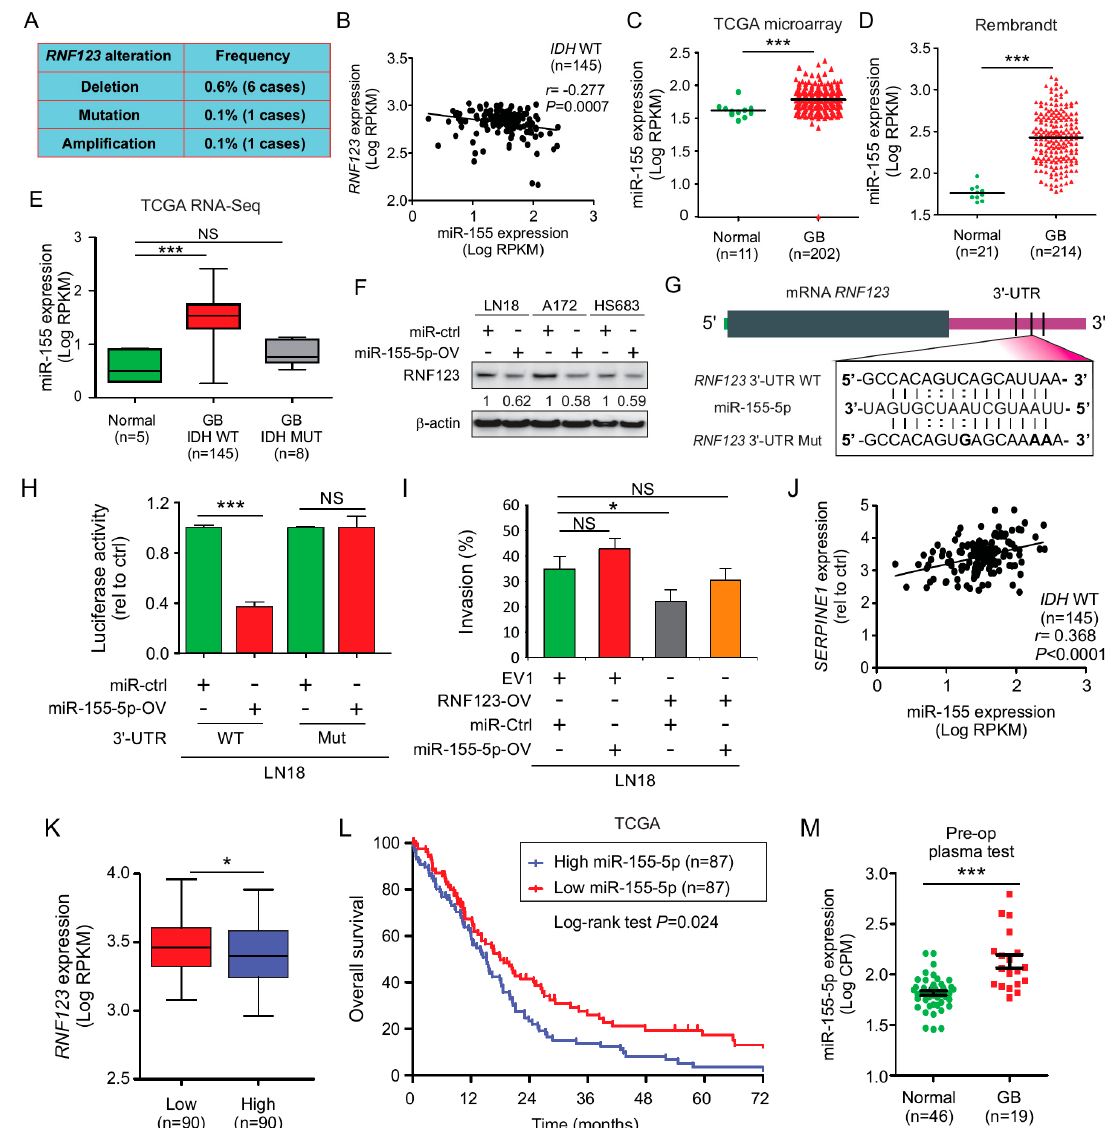
Figure 6. MiR-155-5p decreased RNF123 expression and gave a poor prognosis in GB patients. ( A ) TCGA analysis of a merged cohort of low-grade glioma and GB for copy number variations and mutations. The frequency of RNF123 alteration is 0.8% of a total of 1084 patients. ( B ) Correlation analysis of miR-155-5p and RNF123 expression using TCGA dataset from GB tumors ( n = 145; Pearson r = − 0.277, p = 0.0007). ( C ) TCGA database analysis of miR-155 in GB tissue ( n = 202) compared to normal brain tissue ( n = 11) ( t -test, *** p < 0.001). ( D ) Rembrandt database analysis of miR-155 expression in GB tissue ( n = 214) compared to normal brain tissue ( n = 21) ( t -test, *** p < 0.001). ( E ) TCGA database analysis of RNA-sequencing data for miR-155 in IDH WT ( n = 145) or mutated ( n = 8) GB tissue compared to normal brain tissue ( n = 5) (one-way ANOVA, *** p < 0.001, NS = non-significant). ( F ) LN18, A172, and HS683 cell lines were transfected with pre-miR-155-5p (miR-155-5p-OV) or miR control (miR-Ctrl) and RNF123 expression was quantified by Western blot. ( G ) miR-155-5p sequence aligned with human RNF123 WT 3 (cid:48) -UTR (WT) and RNF123 Mutant 3 (cid:48) -UTR (Mut) sequences. ( H ) Luciferase reporter activity assay to determine the e ff ect of miR-155-5p on 3 (cid:48) -UTR of RNF123 using human RNF123 3 (cid:48) -UTR (WT) and RNF123 Mutant 3 (cid:48) -UTR (Mut) sequences cloned in RenSP vector ( t -test, NS = non-significant, *** p < 0.001). ( I ) Percentage of invasion of LN18 cell lines with miR-155-5p-OV, RNF123-OV, or both compared to control cell lines (one-way ANOVA, * p < 0.05, NS = non-significant). ( J )